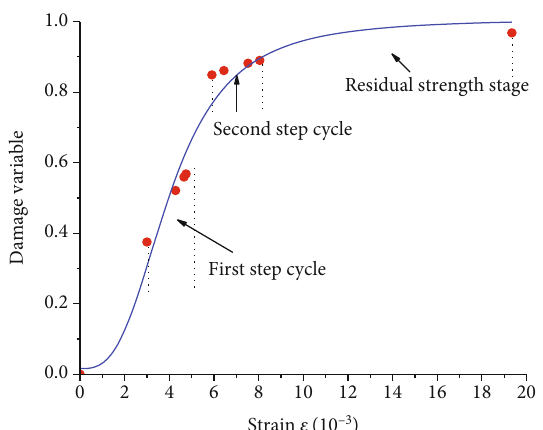
Figure 16: Damage evolution curve for specimen